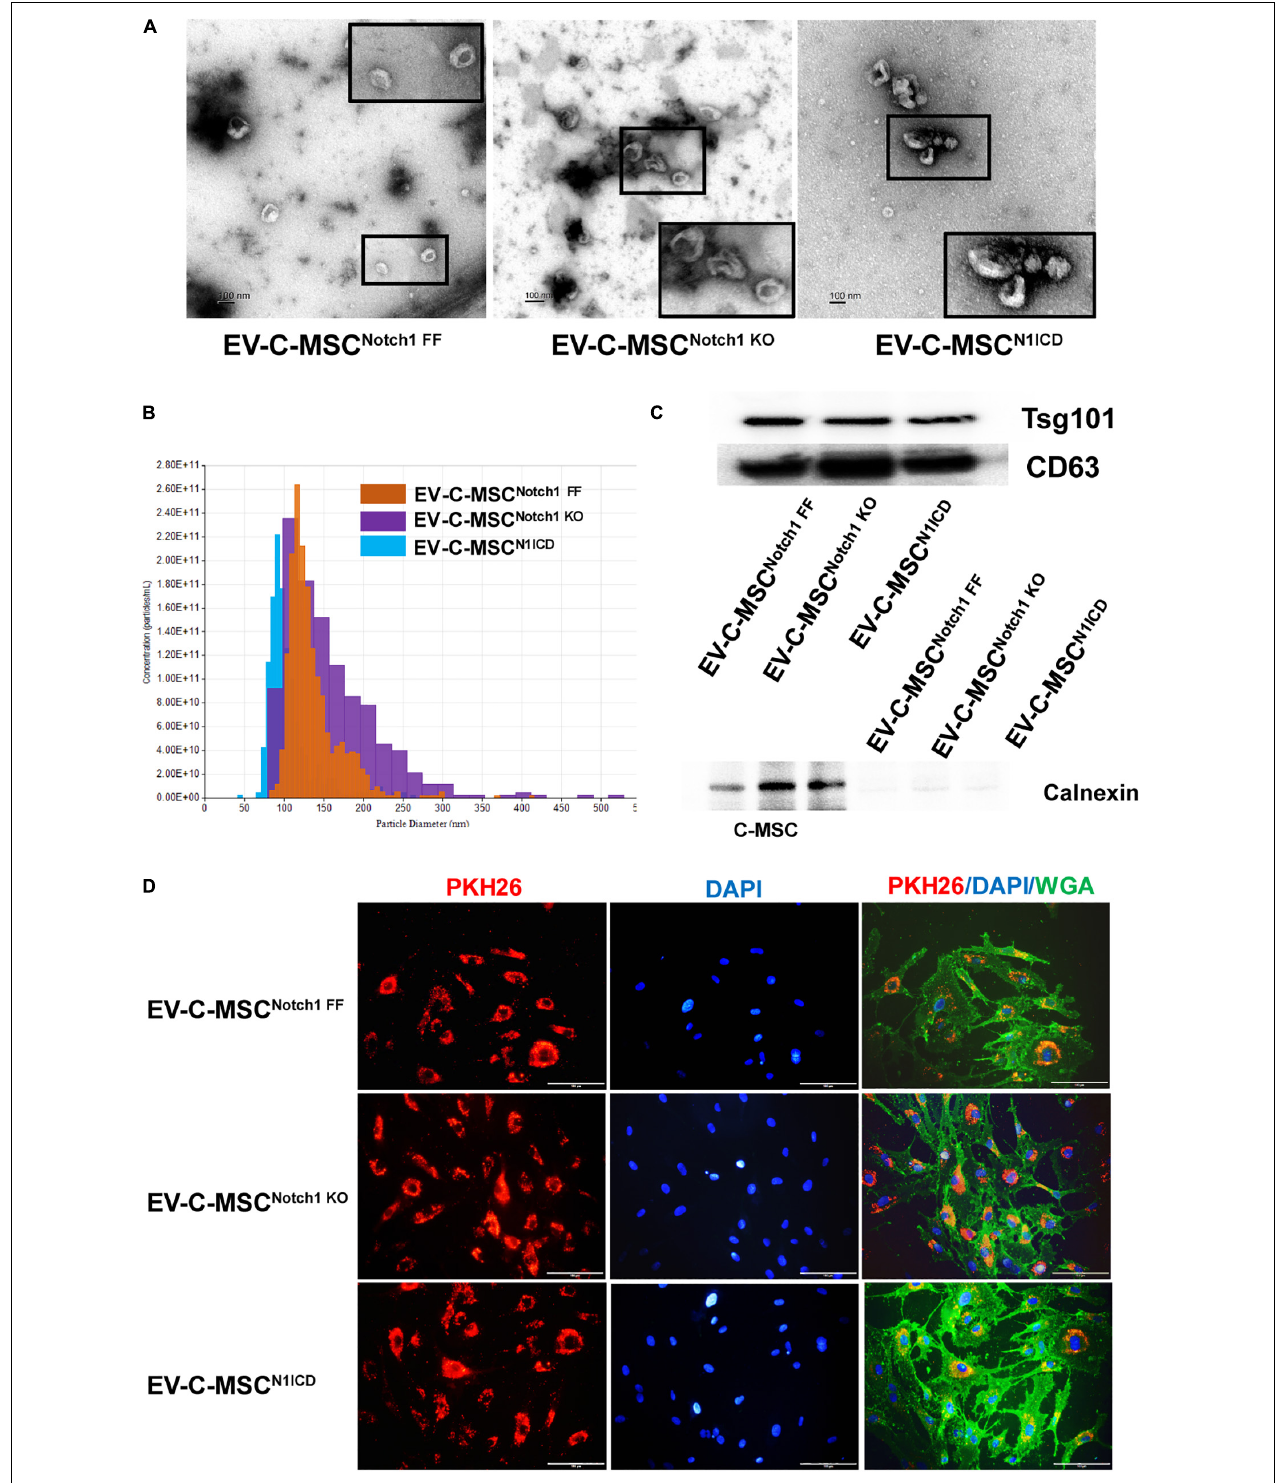
FIGURE 2 | Characterization and internalization of extracellular vesicles from C-MSCs. (A) Extracellular vesicles (EVs) secretion from the different C-MSCs as imaged by transmission electron microscopy (TEM). Inset shows higher magnification of EVs. Bar = 100 nm. (B) Representative graph of size distribution of EVs from C-MSCs Notch1FF , C-MSCs Notch1KO , and C-MSCs N1ICD detected by tunable resistive pulse sensing (TRPS). (C) Representative images of western blot showed that EVs from C-MSCs Notch1FF , C-MSCs Notch1KO , and C-MSCs N1ICD were enriched in EV-specific marker CD63 and Tsg101. Negative marker calnexin was not expressed in EVs. (D) EV internalization in cardiac microvascular endothelial cells (CMVECs). PKH26-labeled EVs (red) from different groups of C-MSCs were observed inside the CMVECs (green, WGA), mostly located at the perinuclear region. Bar indicates 100 µ m.